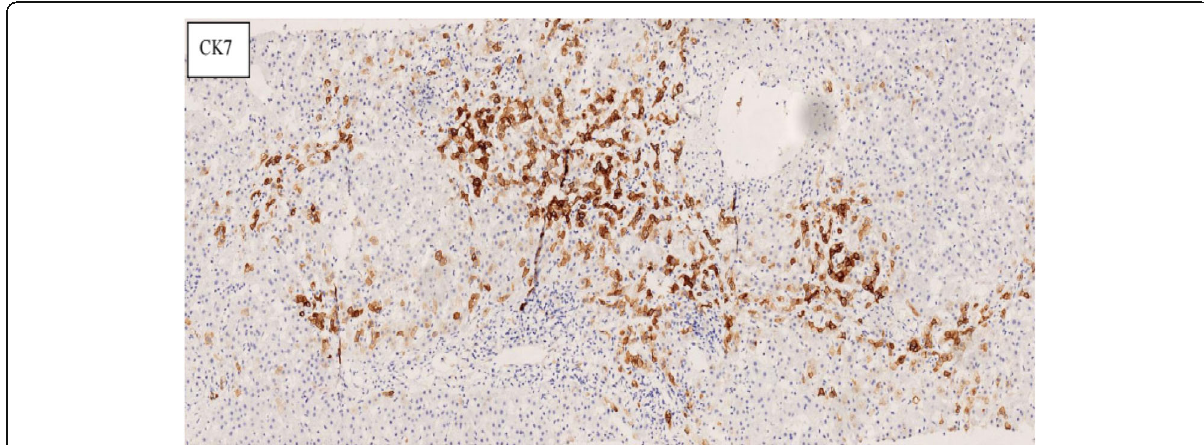
Fig. 3 Hepatic tissue of IHC, immunohistochemistry for CK7. It can improve the diagnosis of VBDS and PBC more